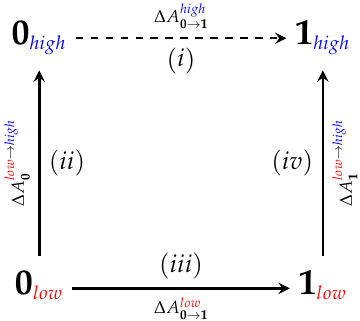
Figure 1. The indirect cycle underlying (S)QM/MM FES. “0” and “1” denote the two physical end states, e.g., a molecule in gas phase and solution, or a ligand in the free state and bound to a